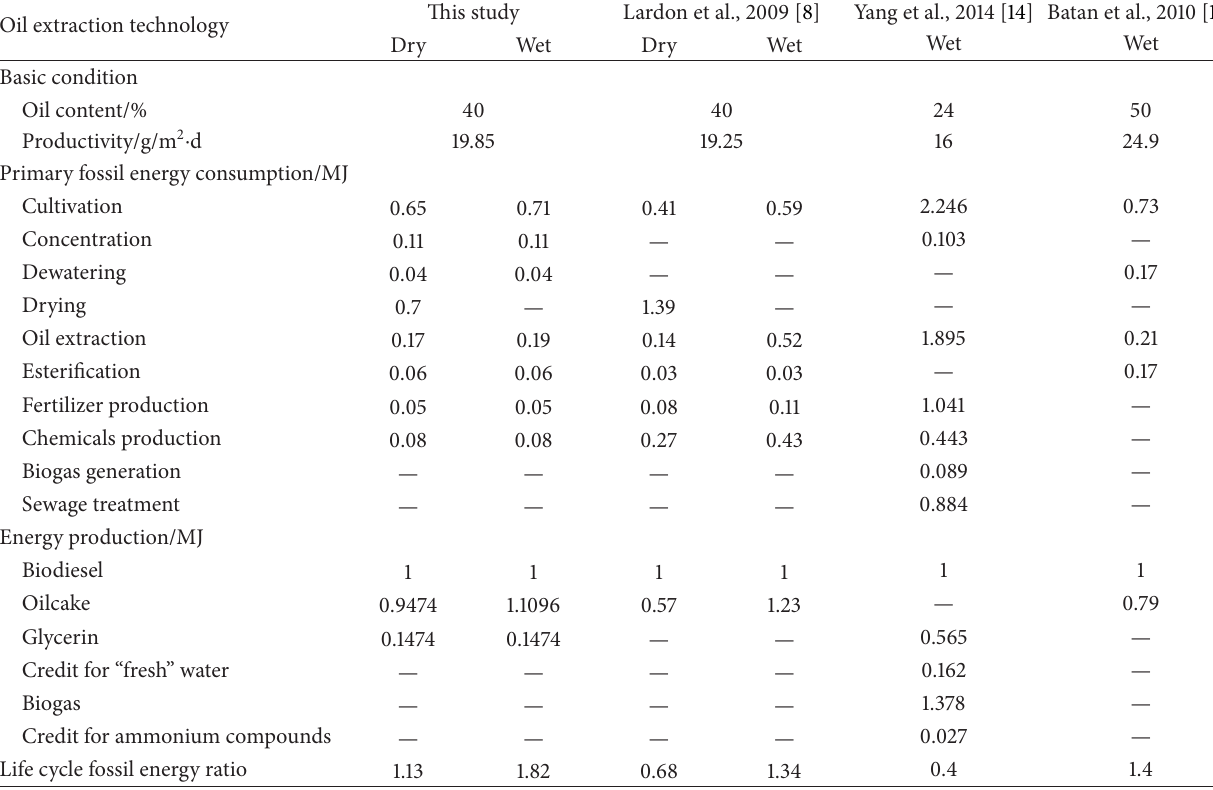
Table 5: The primary energy demands, energy outputs, and life cycle fossil energy ratios for algal biodiesel production in different researches. Oil extraction technology